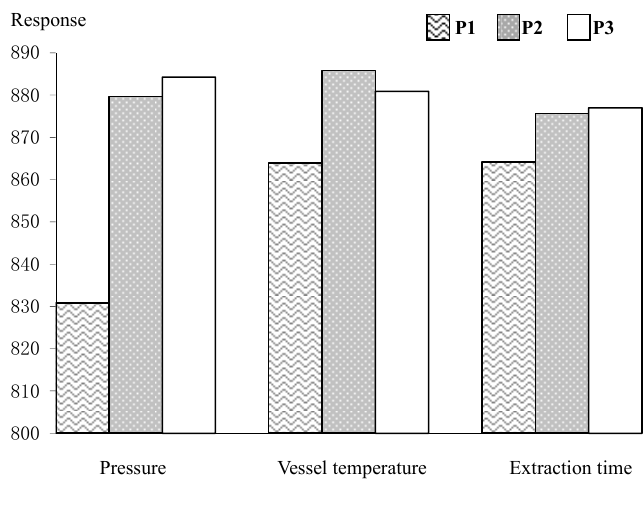
Figure 2. Influence of system pressure, vessel temperature and static extraction time on SFE of three investigated compounds in the volatile oil from the roots bark of O. horridus . Conditions: The investigated levels of selected factors, 320 bar, 360 bar, and 400 bar as extraction pressure, 35 °C, 40 °C and 45 °C as temperature and 2.5 h, 3 h and 3.5 h as static extraction time were defined as P1, P2, and P3, respectively. To determine one of the parameters, the others were set at the selected default values (temperature, 40 °C; vessel pressure, 360 bar ( ca. 5220 psi); static extraction time, 3 h).